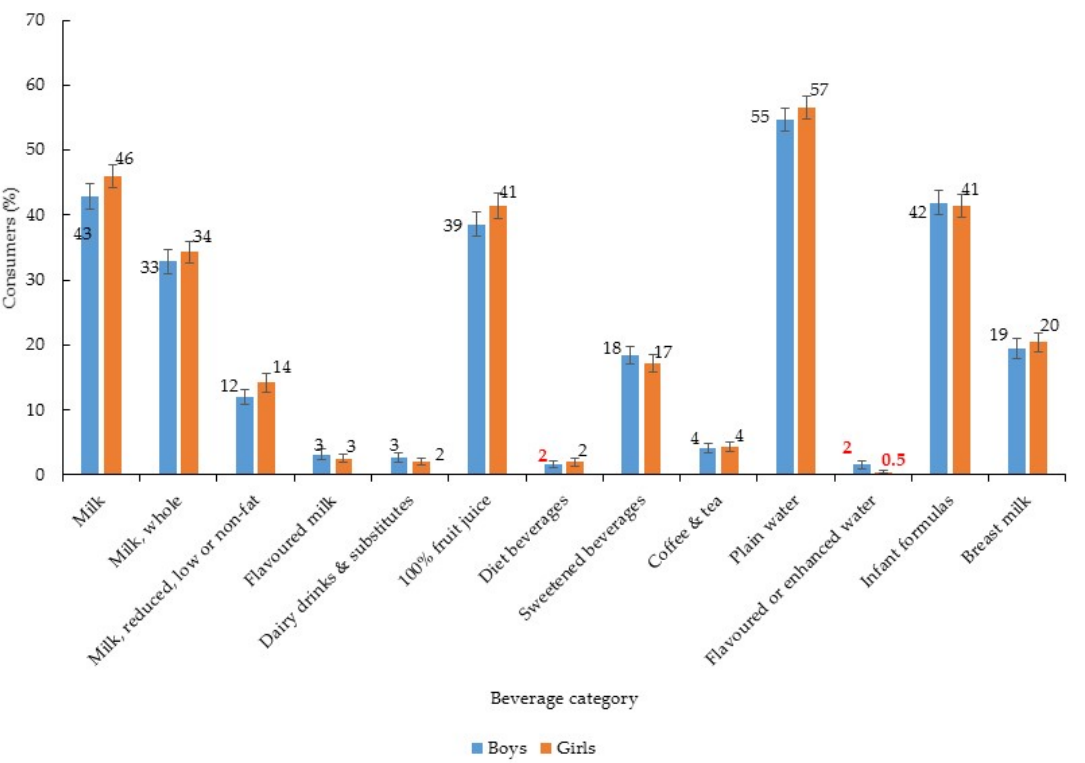
Figure 2. Proportion (%) of children consuming each type of beverage by sex ( n = 2740) 1,2 ; 1 Error bars represent ± 1 SE. Those bolded in red are statistically unreliable, relative standard error ≥ 30% [24]; 2 Chi-square test to assess difference in proportions. No significant differences between boys and girls for any beverage category.